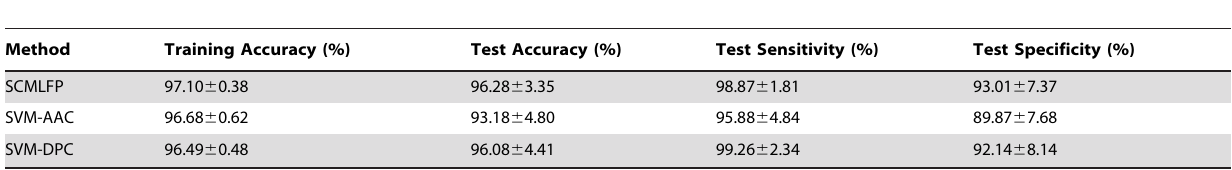
Table 7. The performance (%) of SCMLFP and the compared SVM-based methods on the dataset consisting of 269 luciferases and 216